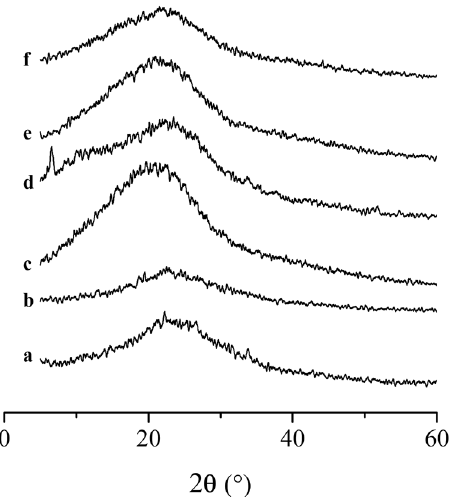
Figure 2: XRD of carbon microspheres prepared under di ff erent conditions. Samples ( a – c ) were prepared at 90°C for 30 min with di ff erent concentrations of HCl: ( a ) 18.5%, ( b ) 25.9%, ( c ) 37.0%. Samples ( d – f ) were prepared at 90°C for 120 min with di ff erent concentrations of HCl: ( d ) 18.5%, ( e ) 25.9%, ( f )